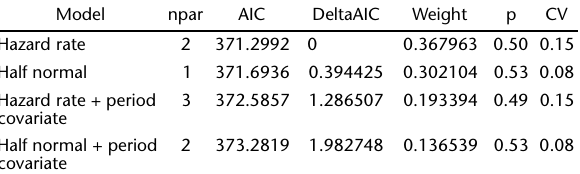
Table II. Summary of model selection statistics for the pooled marsh deer data.